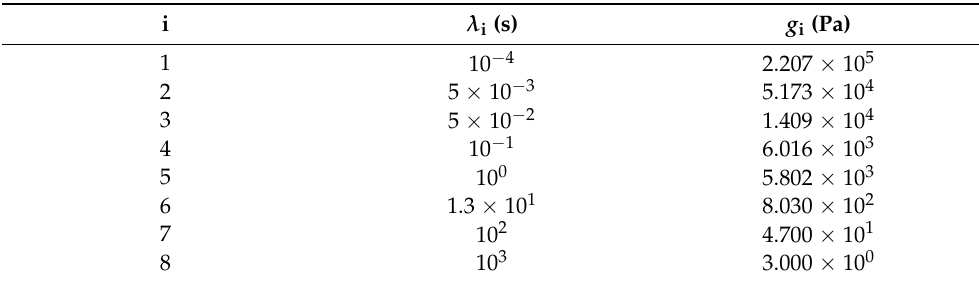
Table 5. Relaxation spectrum of the LDPE melt obtained after long-term dynamic shear sweep (300 s) at large strain (300%) at 150 ◦